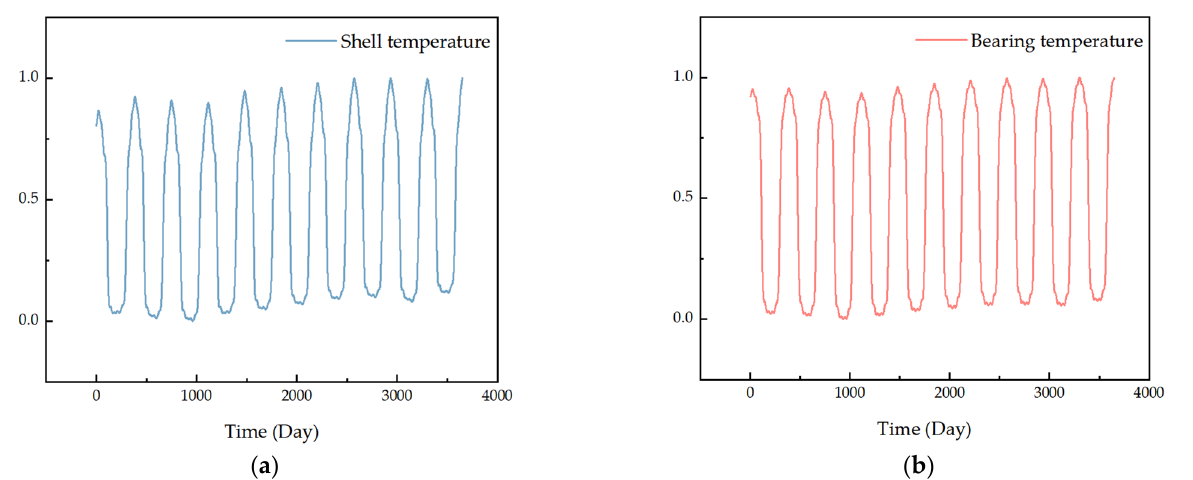
Figure 6. Positive normalization of ( a ) shell temperature and ( b ) bearing temperature. Table 2. Results of the calculation of the parameter weights. Weighting of Weighting of Shell Temperature Bearing Temperature CRITIC method 0.4758 0.5242 Entropy method 0.4883 0.5117 Combined weighting 0.4821